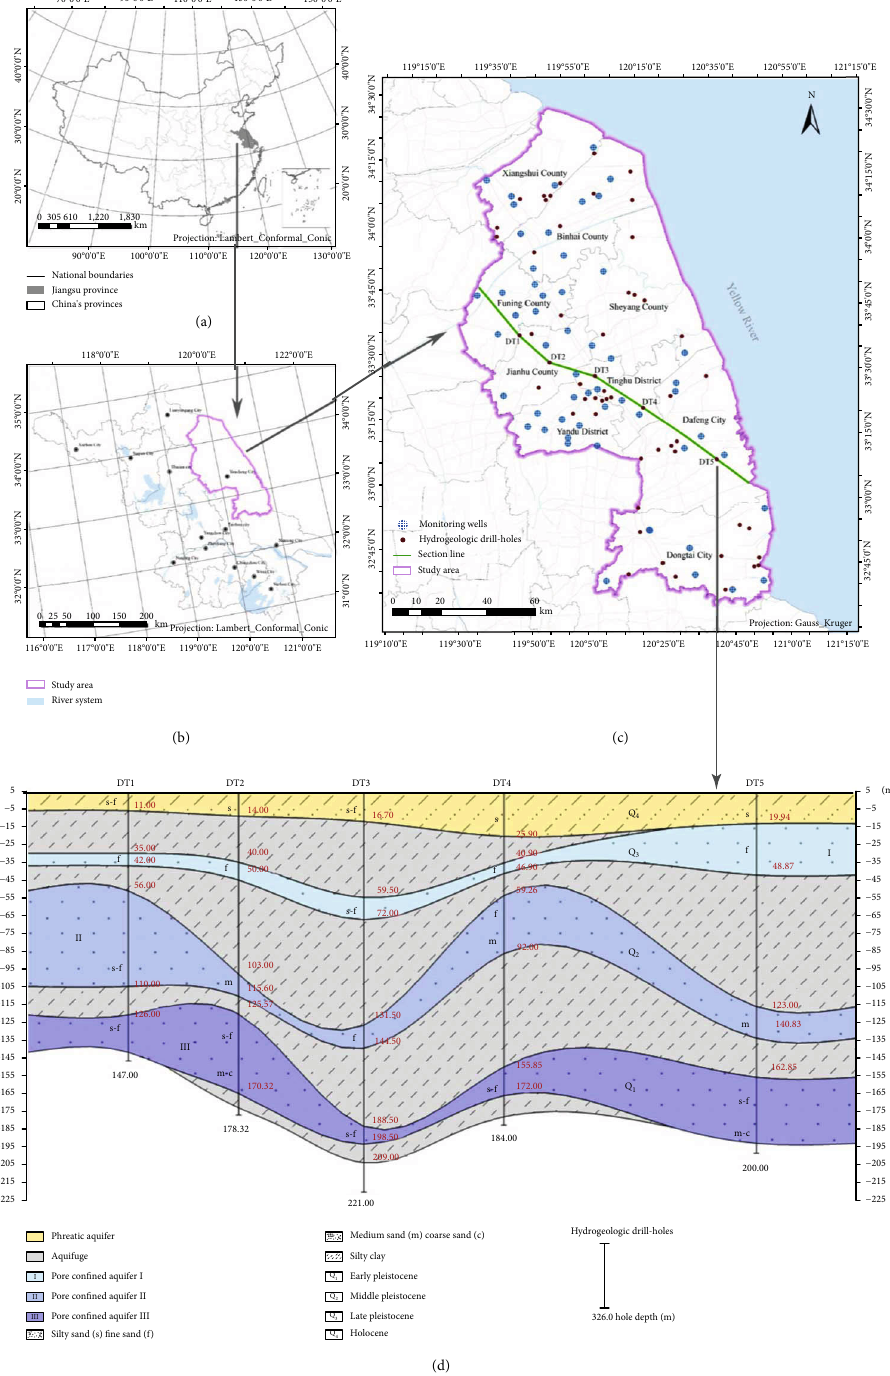
Figure 1: Map of the study area and its geographical location. (a) Jiangsu Province, east coast of China; (b) Yancheng City; (c) spatial location of wells and hydrogeologic drill holes and (d) hydrogeological